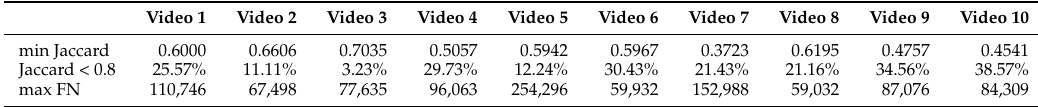
Table 2. Mask R-CNN vs. BRemNet video segmentation test ( n = 10).